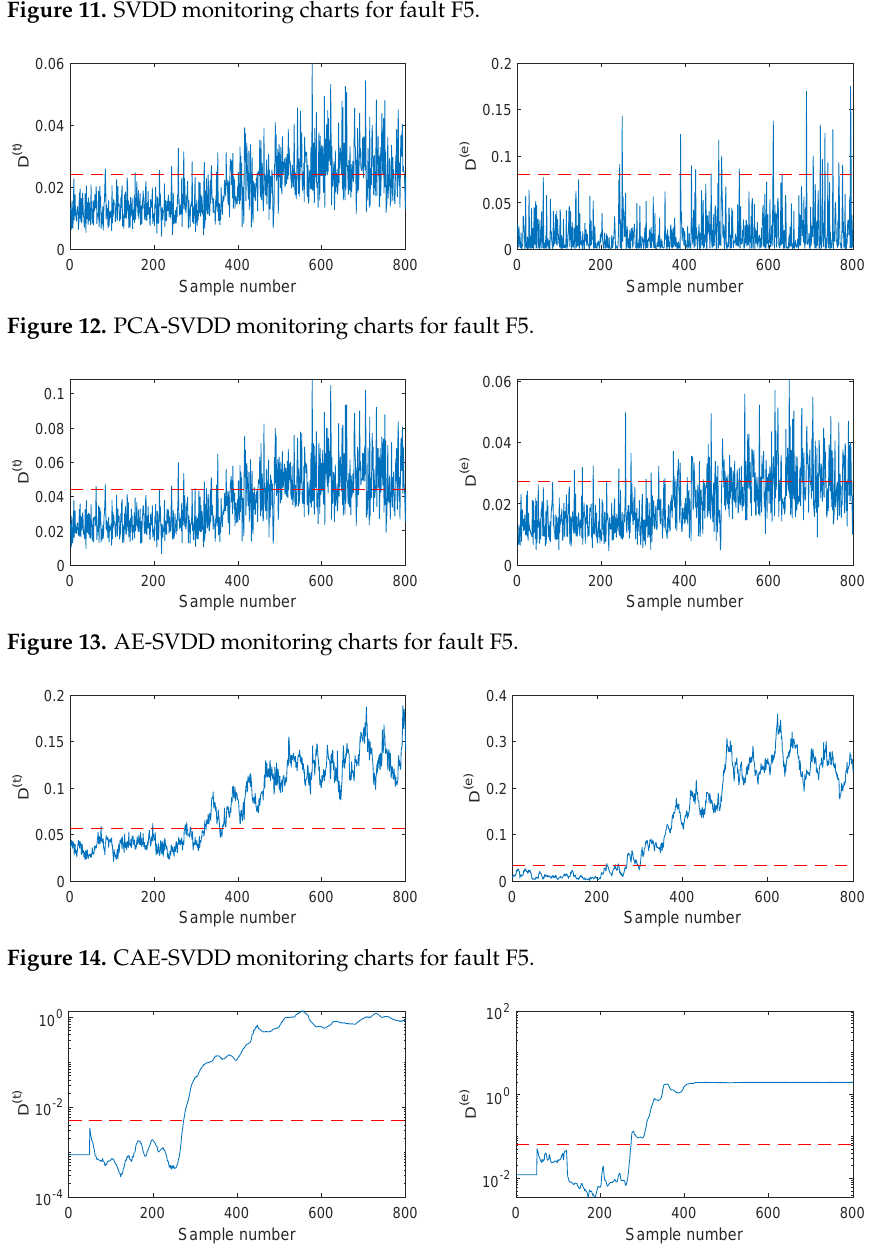
Figure 15. DPSVDD monitoring charts for fault